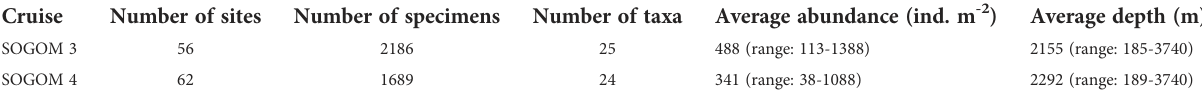
TABLE 1 Number of sites, specimens, and taxa. Average abundance and depth for each cruise.